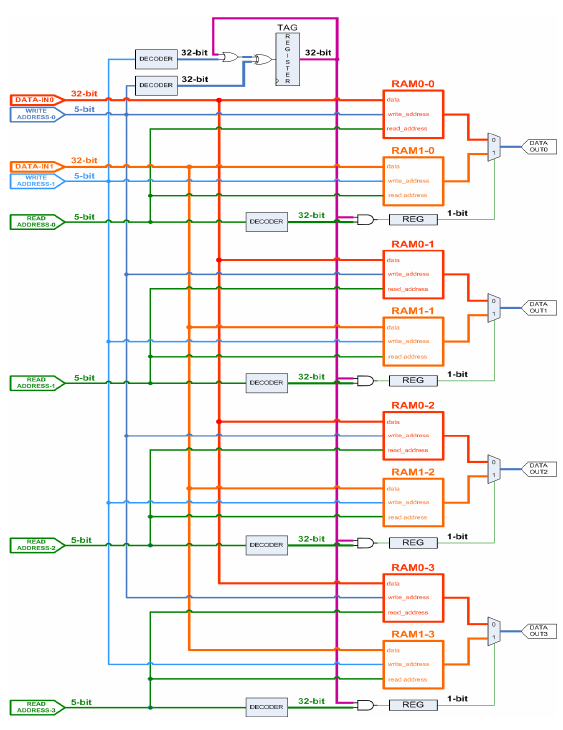
Figure 12. Two write and four read ports